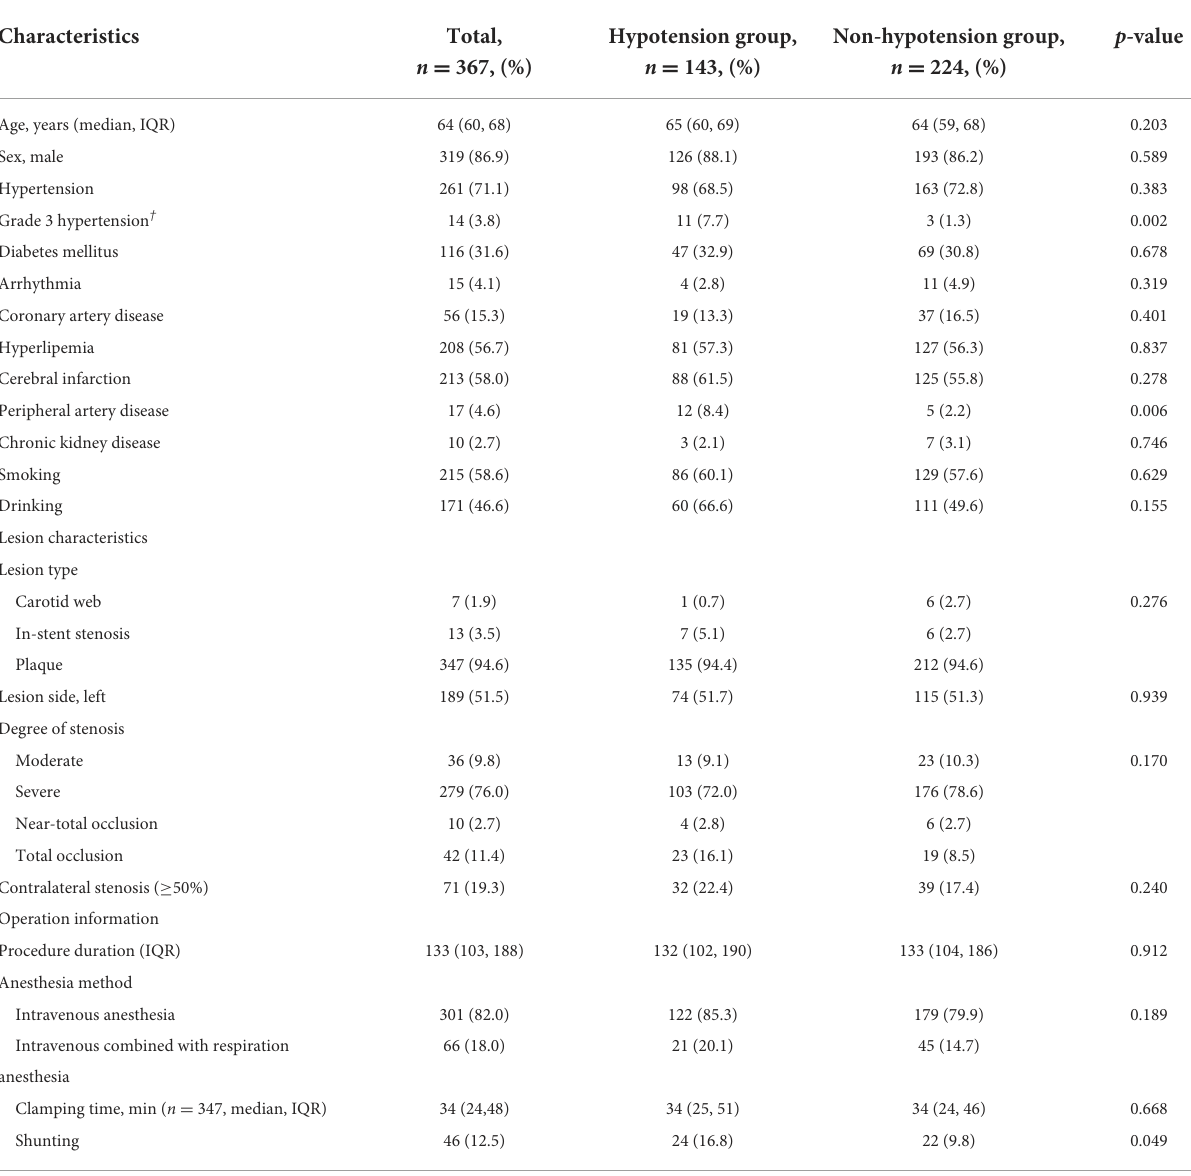
TABLE 1 Baseline characteristics of patients’